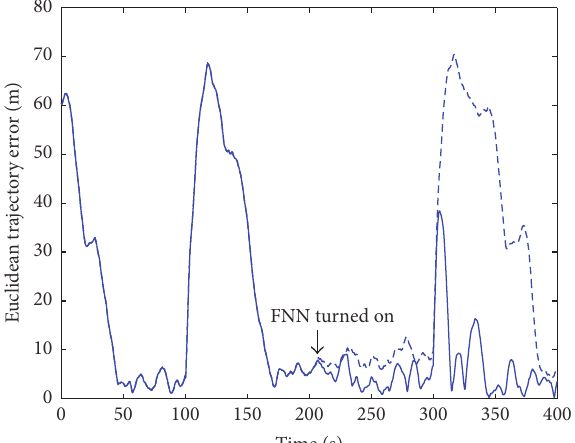
Figure 7: Time response of the Euclidean error between the actual and reference trajectory for the P controller acting alone (dashed line) and the FNN in parallel with the P controller (solid